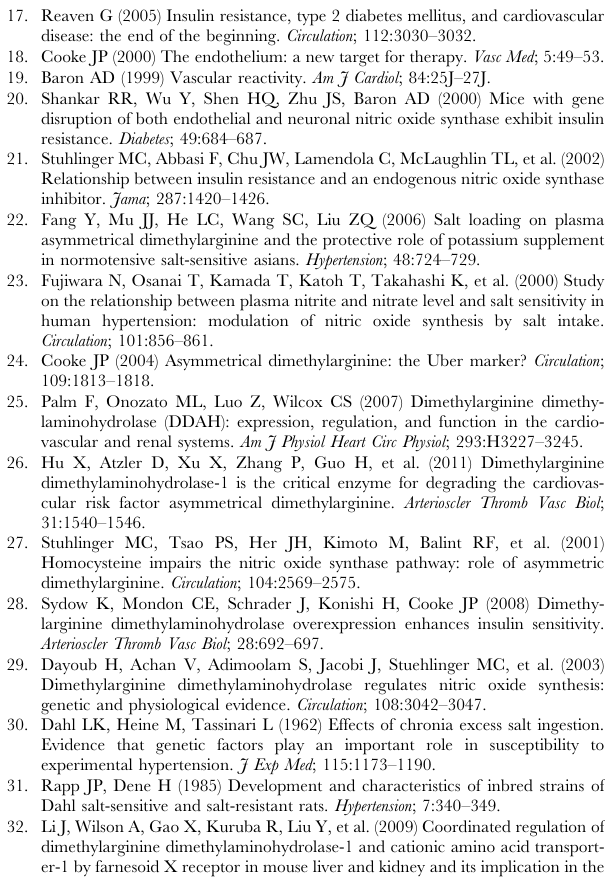
weight to the respective body weight at time of sacrifice. Lungs and kidneys weight was combined total weight for the right and left tissues. Data is expressed as Mean 6 SEM. (*p , 0.05 versus low-salt diet data. ANOVA followed by Bonferroni post-test). Figure S2 Assessing the effect of INT-747 on Pulmonary Arterial (PA) pressure. Animals were intubated and catheter was inserted into the PA for pressure measurement in low salt, vehicle, INT-747 (10 mg/kg/day) and INT-747 (30 mg/kg/day) groups. Data is expressed as Mean 6 SEM. Figure S3 Assessment of renal function by measuring urinary creatinine and albumin. The urinary creatinine and albumin values were normalized to 24 h urine output and the urinary-albumin-to-creatinine-ratio (UACR) was calculated as described in the text. Data is expressed as Mean 6 SEM. (*p , 0.05 versus low-salt diet data. ANOVA followed by Bonferroni post-test). Figure S4 Assessment of tissue DDAH activity using a stable-isotope assay in liver lysates of Dahl rats following: LS-(n =9) or HS- diet and administration of vehicle (n =8) or INT-747 at 10 mg/kg/day (n= 8) or at 30 mg/kg/day (n= 9) for 6 weeks. Data is from triplicate experiments and is expressed as Mean 6 SEM. (p . 0.05 among all groups. ANOVA followed by Bonferroni post-test).